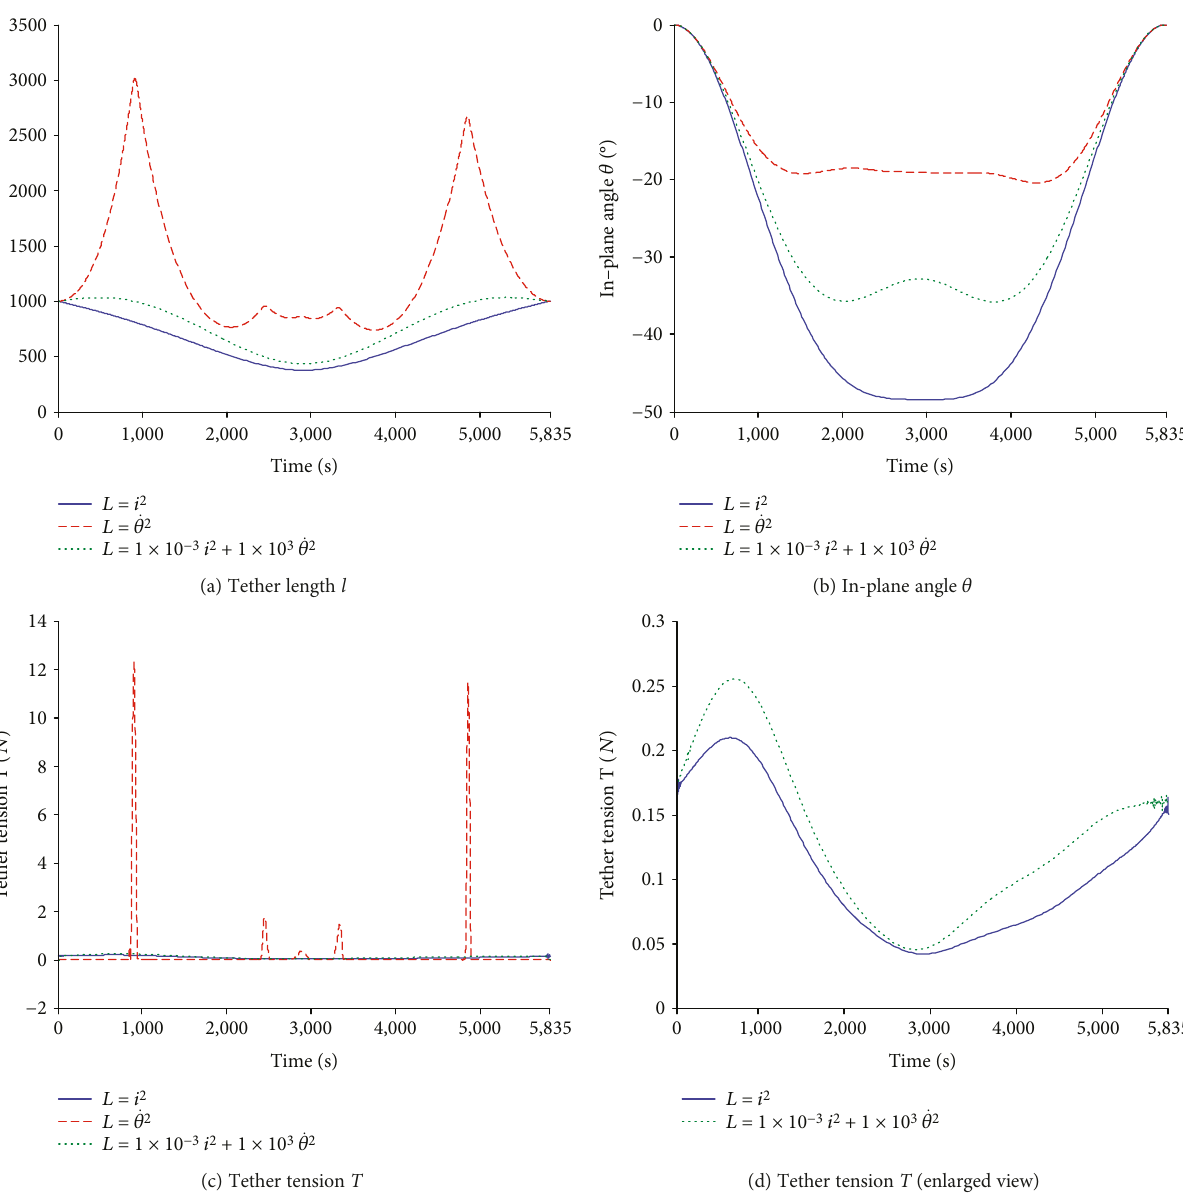
Figure 3: Time responses of the tethered system under tension